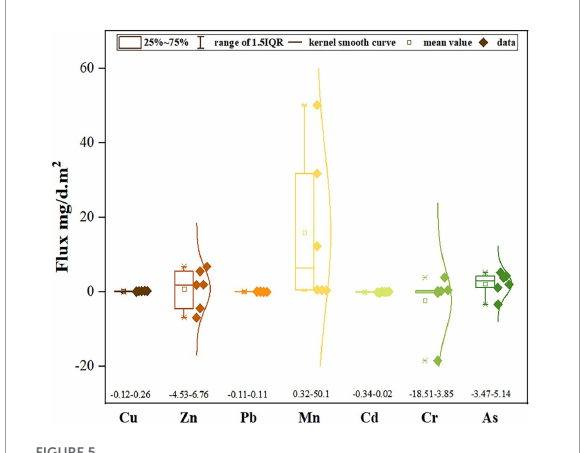
FIGURE5 Diffusion fluxes of metals at the sediment-water interface during the ice-covered